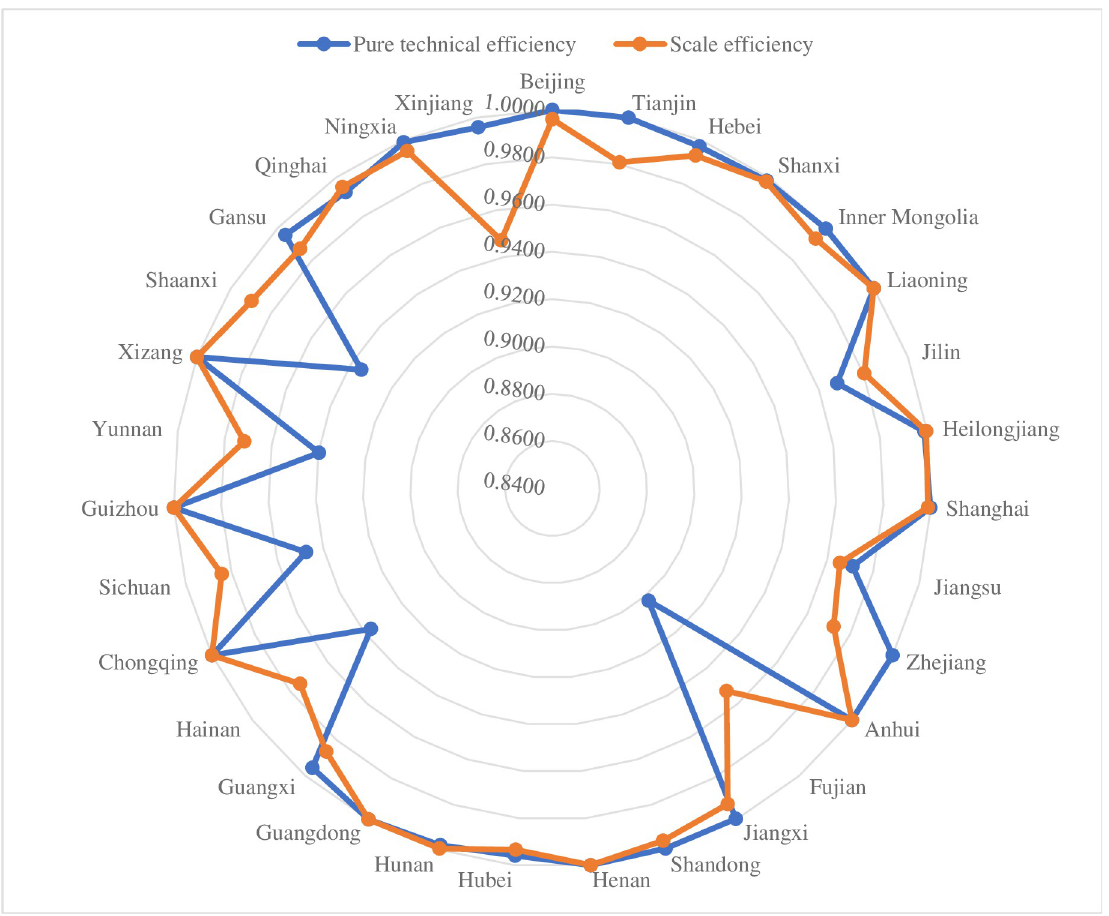
Fig 3. Radar chart of pure technical efficiency and scale